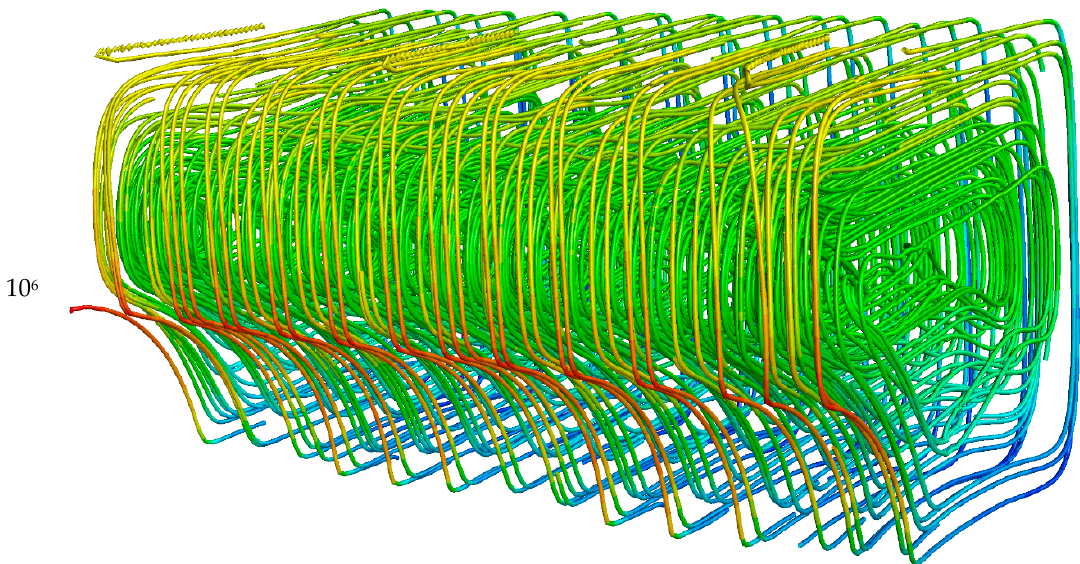
Figure 4. Stream line for Ha = 20, AR = 0.45 − 0.6, γ = 45, ω = 0, ϕ = 0.03, and different Rayleigh number and RAP values.